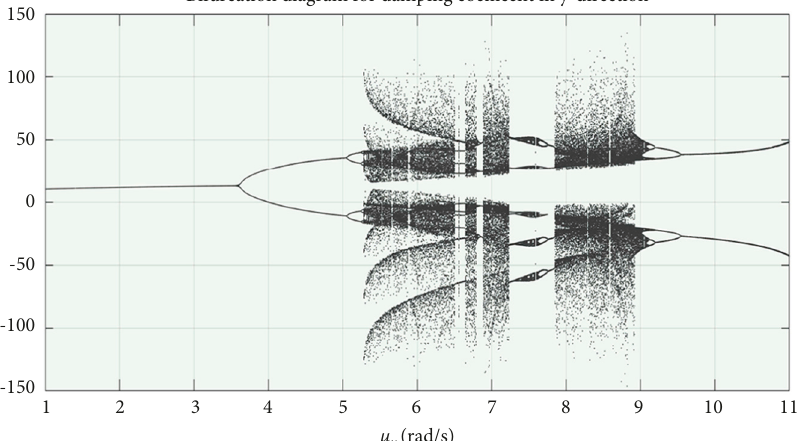
Figure 6: Bifurcation diagram for damping coefficient, μ